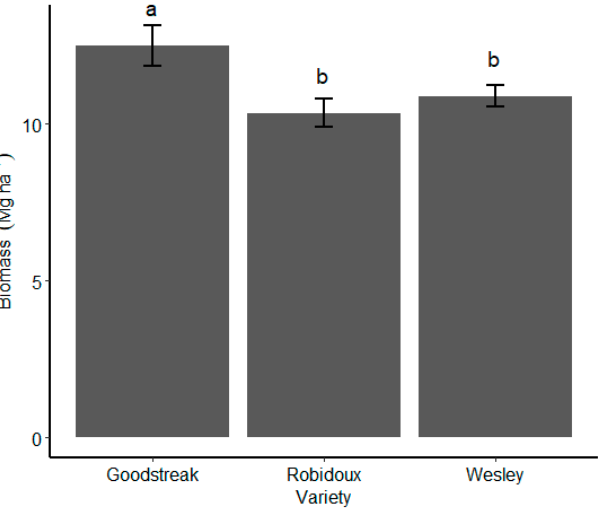
Figure 6. The biomass of winter wheat as affected by varieties planted at McCook experimental site. The error bars represent the standard error of the mean. Different letters on top of column bars indicate a significant mean difference at p < 0.05. Table 4. Analysis of variance showing the effect of planting date, variety, row spacing, and seed rate nested within row spacing and interaction among them on winter wheat biomass, 1000-kernel weight, and tillering. Location names are abbreviated HEM (Hemingford), MC (McCook), and SID (Sidney) .